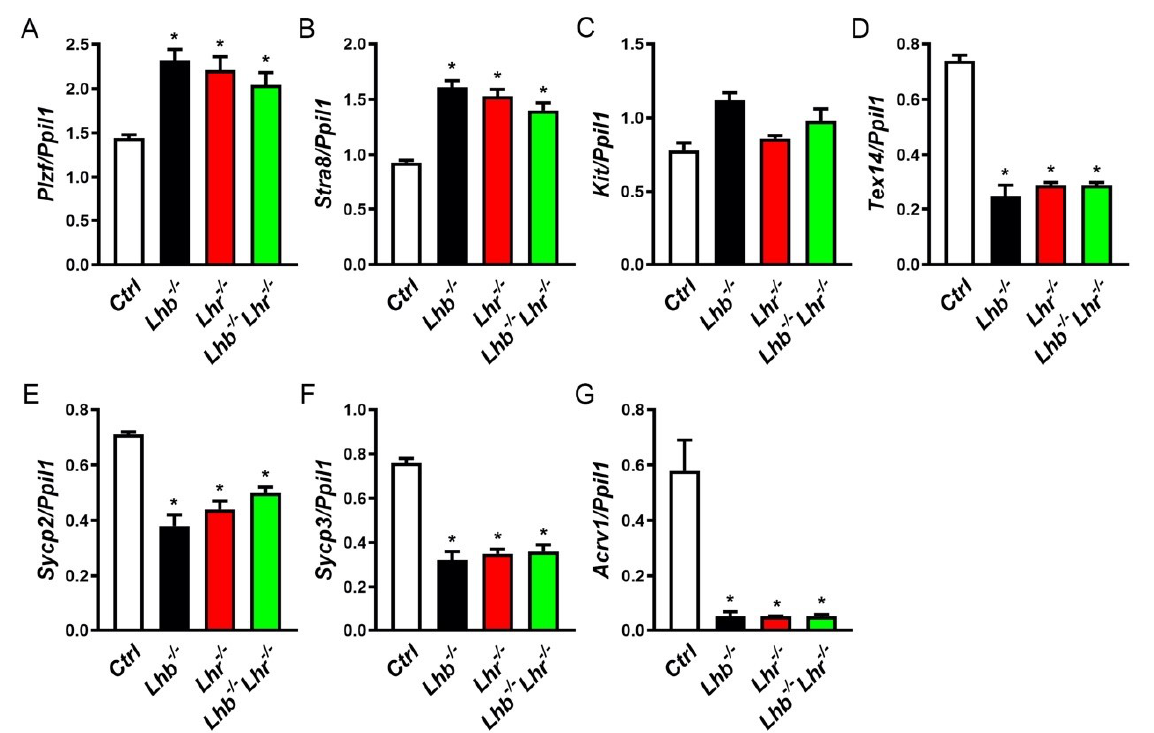
Figure 6. Taqman qPCR analysis of germ cell marker genes. Early germ cell markers such as those expressed in male germline stem cell progenitor ( Plzf , ( A )) and spermatocyte ( Stra8 , ( B ); Kit , ( C )) are upregulated or not affected in the absence of LH or LHR or both. Genes that play critical roles in meiosis ( Tex14 , Sycp2 , Sycp3 , ( D – F )) and spermatids ( Acrv1 , ( G )) are significantly suppressed in single and double mutants. No additive effect of loss of both LH and LHR are noted on expression of any of the genes tested. * p < 0.05, One-way ANOVA, Ctrl vs. Lhb − / − or Lhr − / − or Lhb − / − Lhr − / − ; p > 0.05, One-way ANOVA, Lhb − / − vs. Lhr − / − or Lhb − / − Lhr − / − ; Lhr − / − vs. Lhb − / − Lhr − / − . For all qPCR assays, expression of Ppil1 was used as internal control and cDNA samples in triplicate were used from testis obtained from 3 mice.